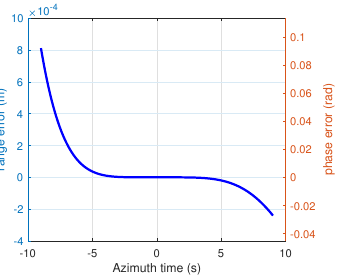
Figure 4. Bistatic range and phase errors of